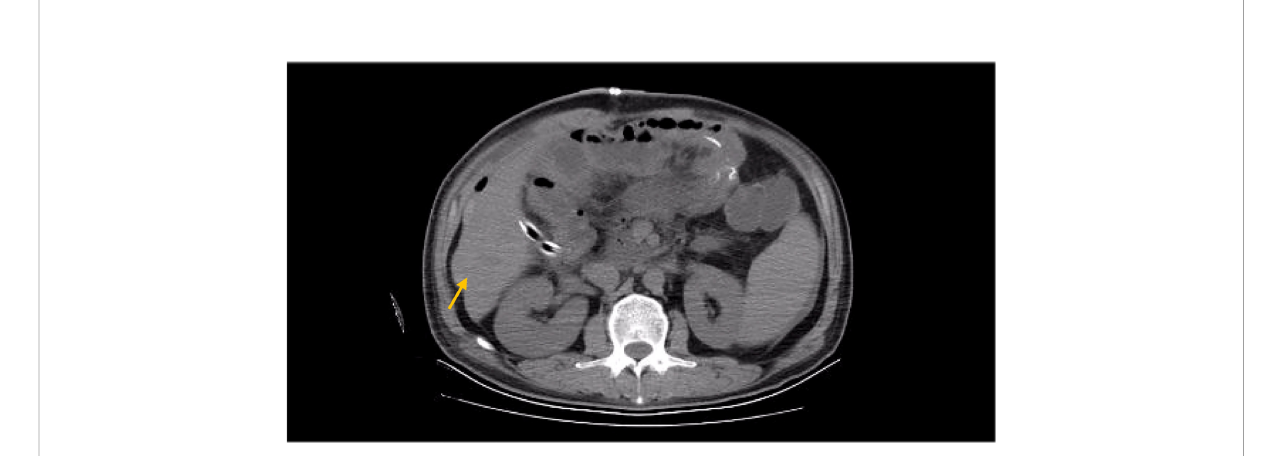
FIGURE 3 CT fi ndings 1 month after surgery (no liver metastasis).